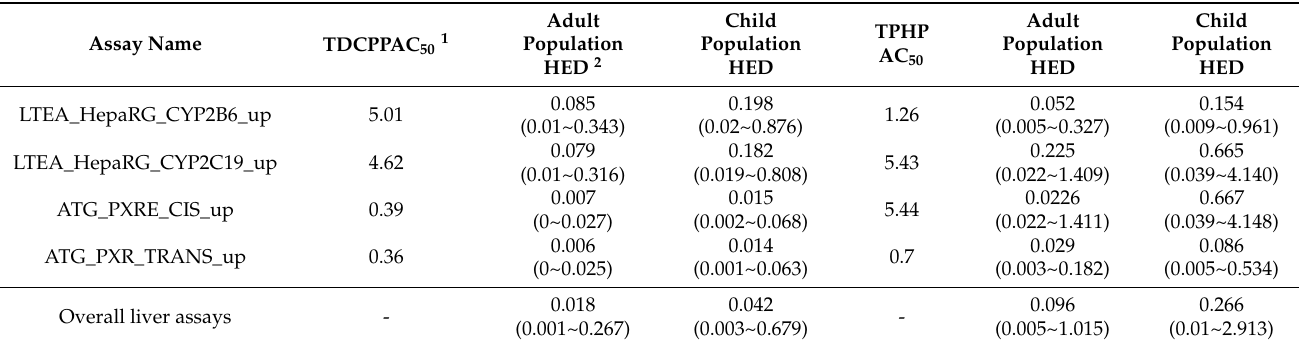
Table 1. AC 50 values and the corresponding estimated HED values for TPHP and